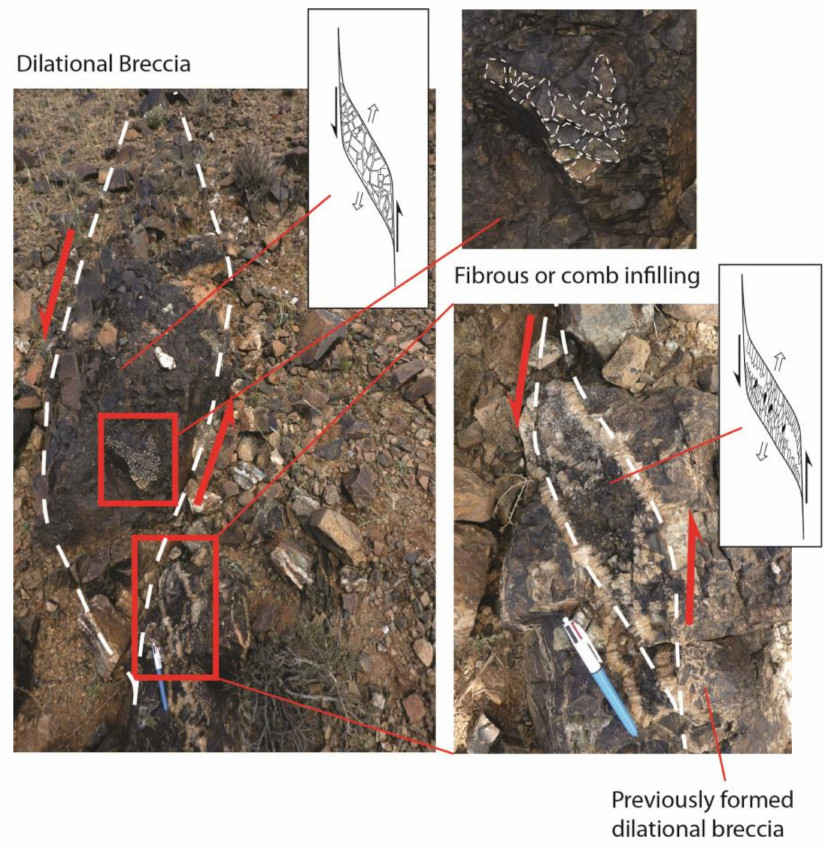
Figure 5. Superposition of dilational breccia texture and fibre/comb ones within similar left-lateral pull-apart structures (see text for explanation of the cause of occurrence of fibrous or breccia